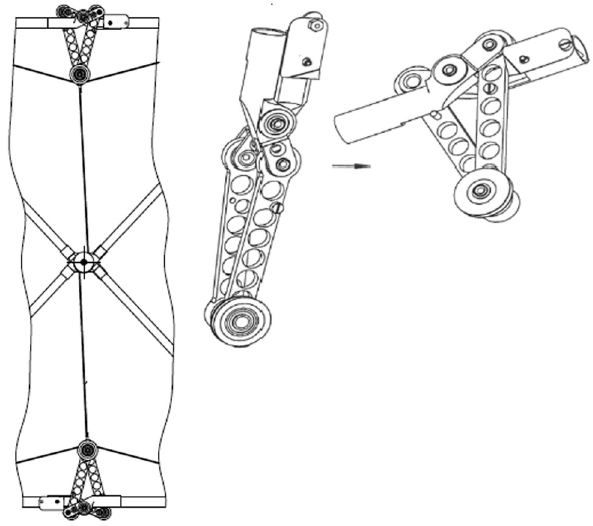
Figure 4: Fixation unit of the V - folding